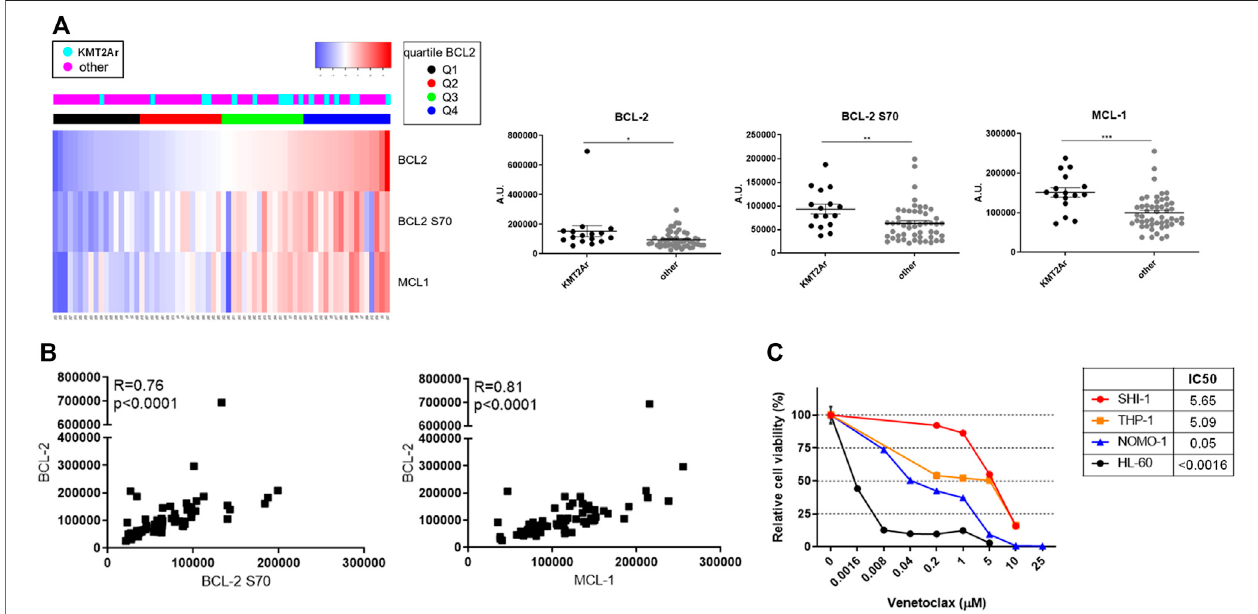
FIGURE1| ExpressionofantiapoptoticproteinsofBCL-2familyinpediatricacutemyeloidleukemia(AML).( A )SupervisedanalysisaccordingtoBCL-2expression (left panel) and dot plots (right panel) showing BCL-2, BCL-2 S70, and MCL-1 protein expression of a cohort of 66 AML pediatric patients subcategorized in KMT2A- rearranged AML and non-KMT2A-rearranged AML, analyzed with the reverse-phase protein array method. Quartiles refer to BCL-2 expression. Dot plots show the mean ± SEM. A.U., arbitrary units. ( B ) Pearson correlation between BCL-2 S70 ( X -axis) and BCL-2 ( Y -axis) in the upper panel and MCL-1 ( X -axis) and BCL-2 ( Y -axis)inthelowerpanel; p < 0.00001.( C )Dose – responsecurveofgrowingconcentrationsofvenetoclaxinKMT2A-rearrangedAML(SHI-1,THP-1,andNOMO-1)and non-KMT2A-rearranged AML (HL-60) cell lines at 72 h after treatment ( n = 2).